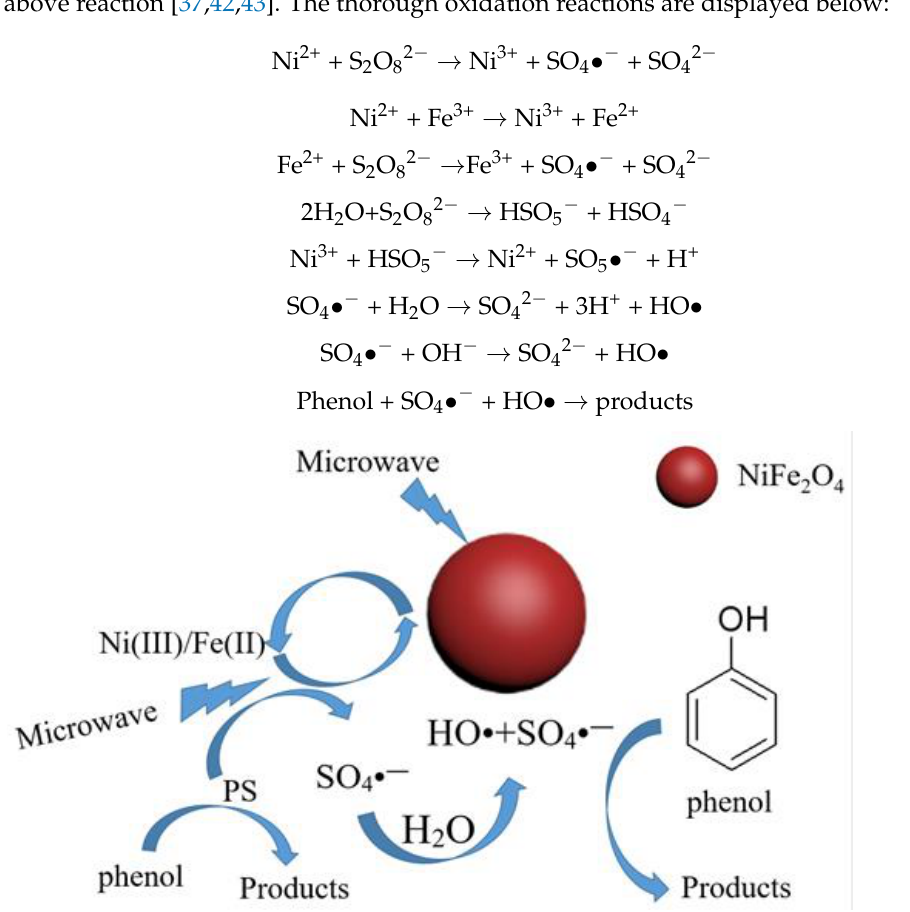
Figure 5. Proposed mechanism of NiFe 2 O 4 system for phenol degradation.